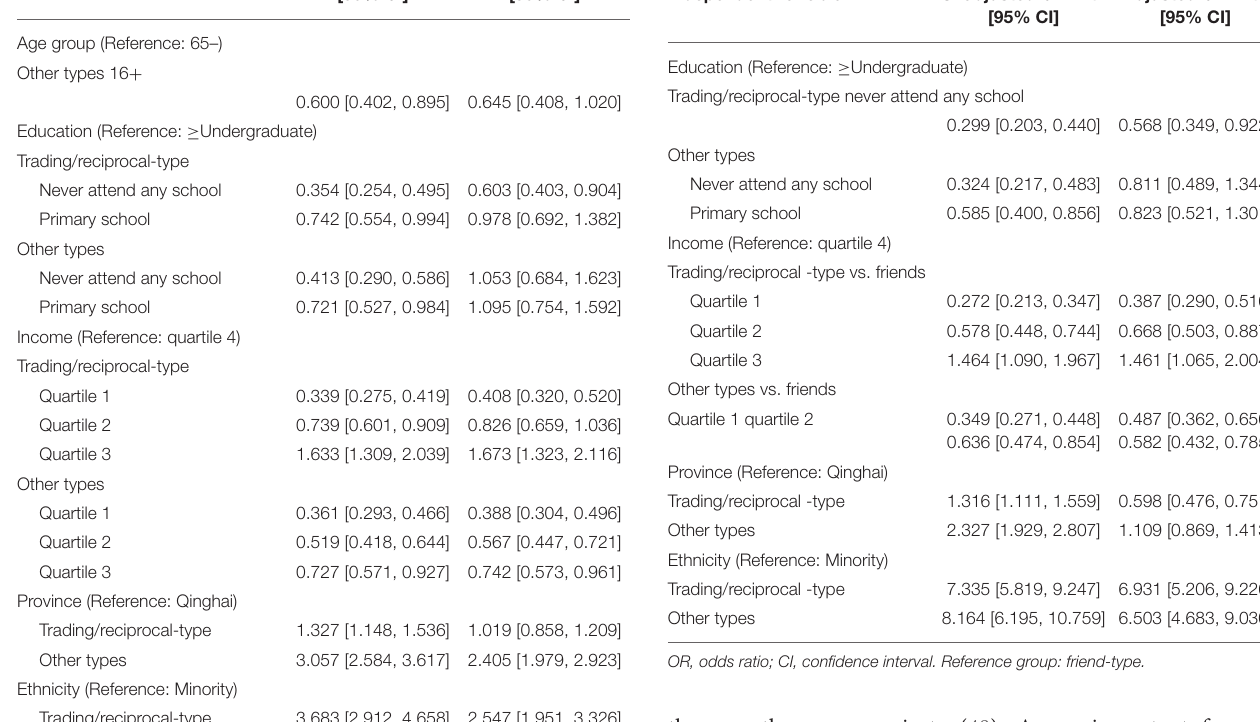
TABLE 6 | Multinomial regression models for relationship with doctors in large hospital. Independent variable Unadjusted OR with [95%